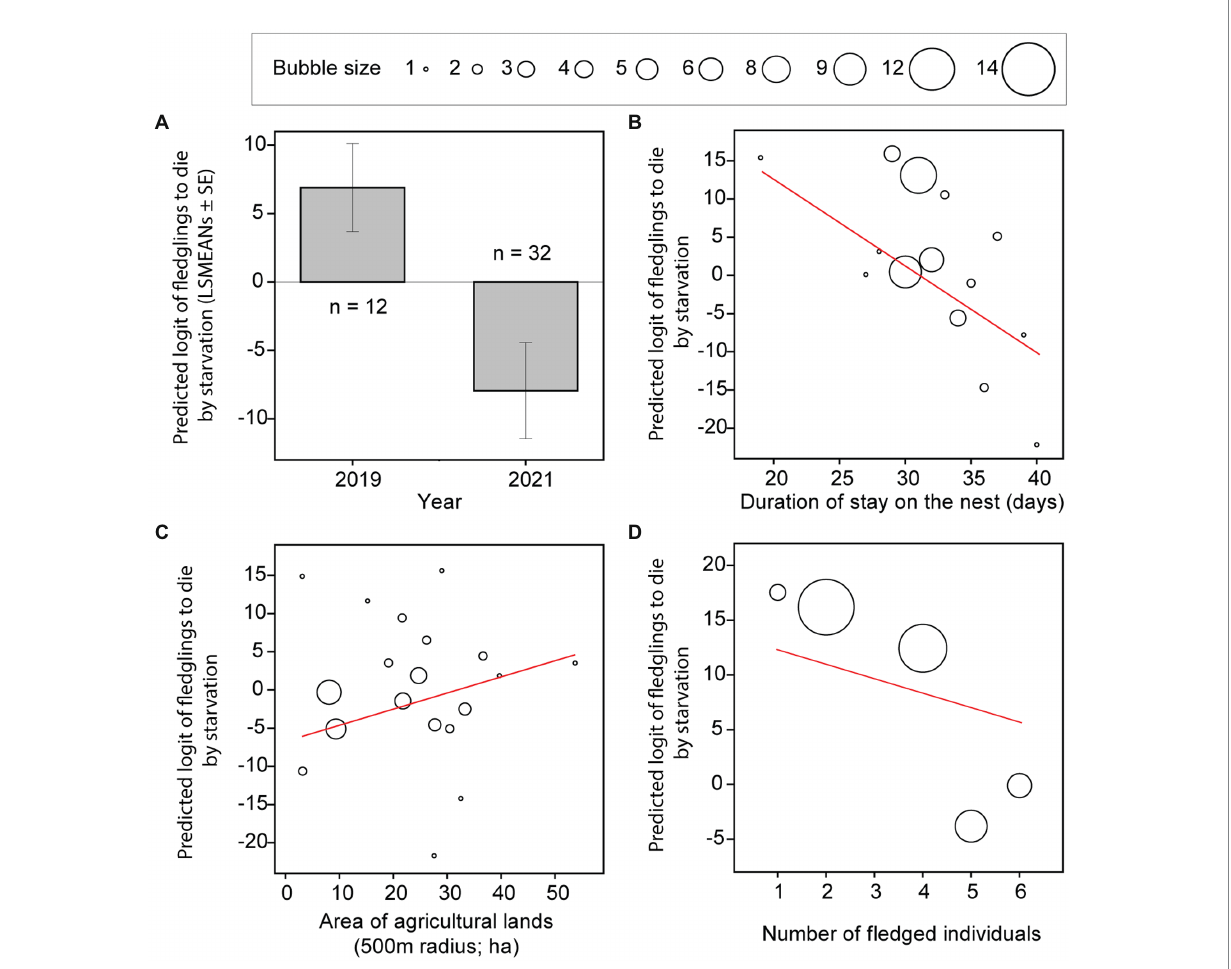
FIGURE 1 Fledglings’ probability of dying by starvation. Least square means (A) and bubble graphs (B–D) of predicted logit values of fledglings’ probability of dying by starvation of Tengmalm’s owl offspring during two post-fledging dependency periods (2019, 2021) (A ; LSMEANs ± SE ) , and plotted against individual nestlings’ duration of stay in the nest (B) , the area of agricultural lands within a 500 m radius from a given nest (C) , and the number of fledged individuals in the brood (D) with regression line (red). The bubble size corresponds to the number of predicted (overlapping) cases between 1 and